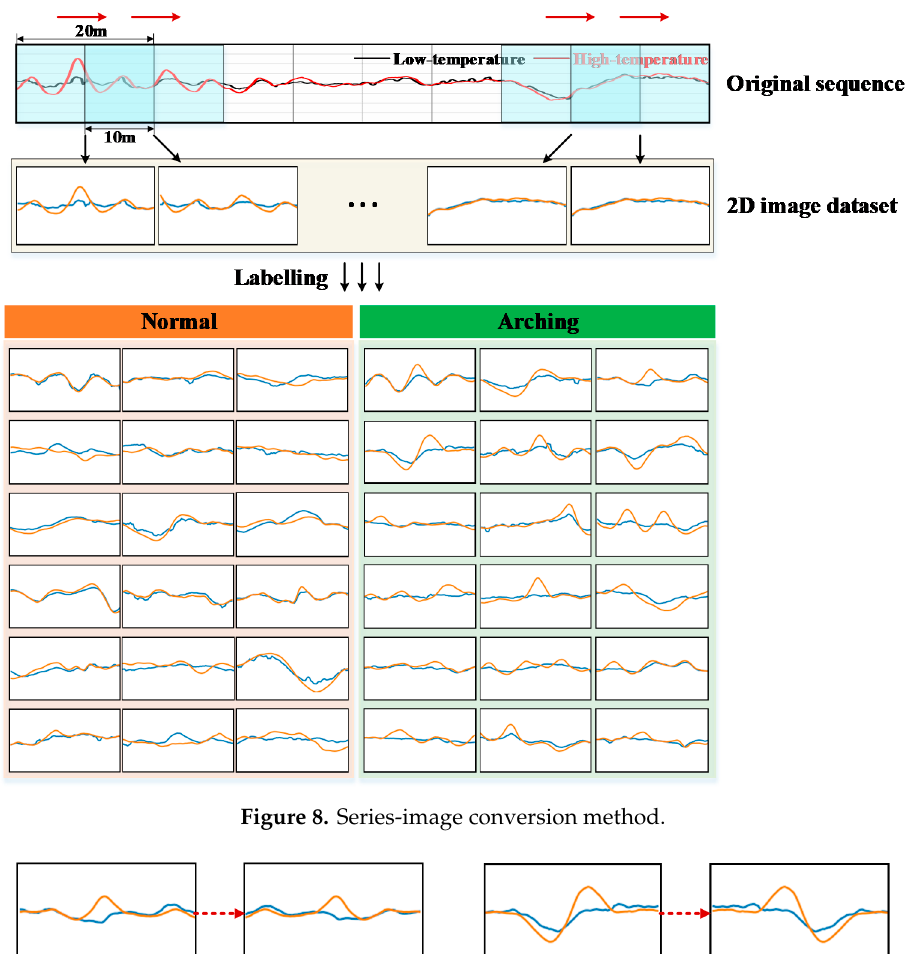
Figure 8. Series-image conversion method.